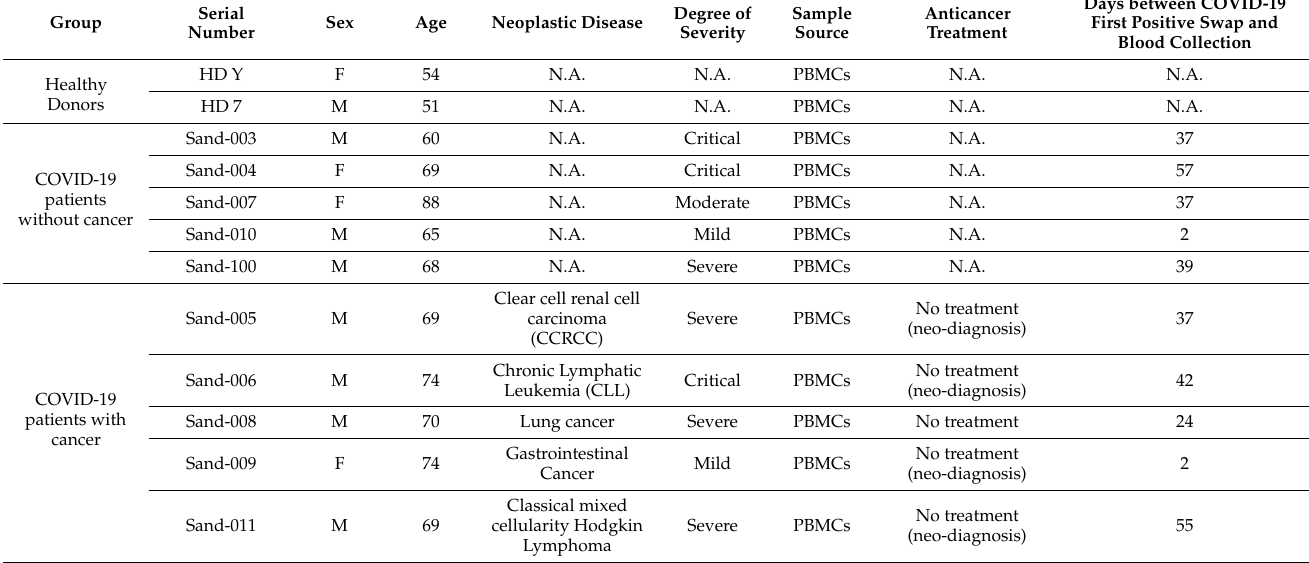
Table 2. The details of the patients and healthy Controls from the GSE164571